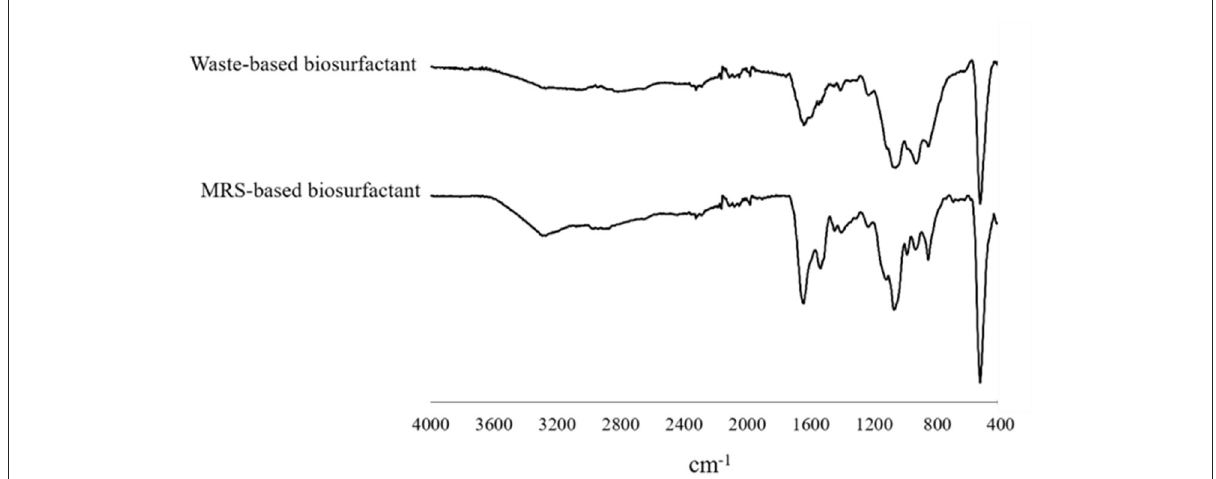
FIGURE4 FT-IR spectral analysis of biosurfactant from L. plantarum ATCC 8014 grown in MRS and waste-based media.